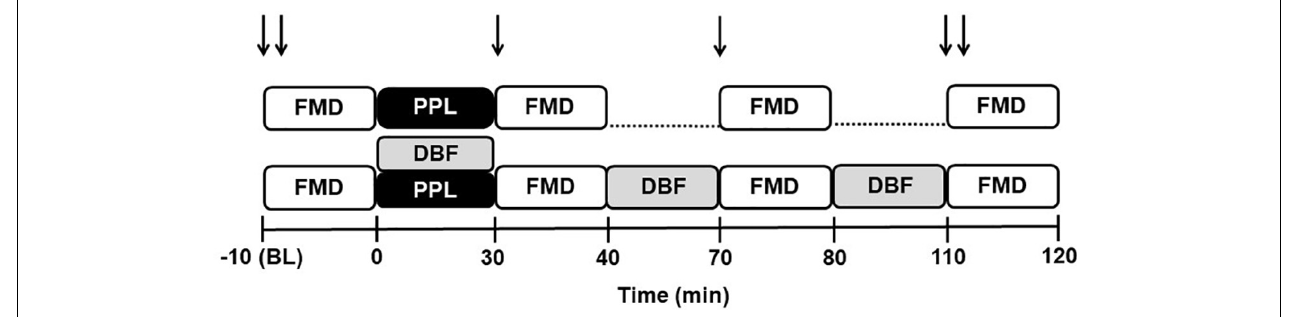
FIGURE 1 | Experimental design for postprandial lipemia (PPL) and PPL plus disturbed blood flow (DBF) sessions. FMD, brachial artery flow-mediated dilation; ↓↓ , oxidative stress, endothelial microvesicles and lipidic profile measurements; ↓ , glucose and lipidic